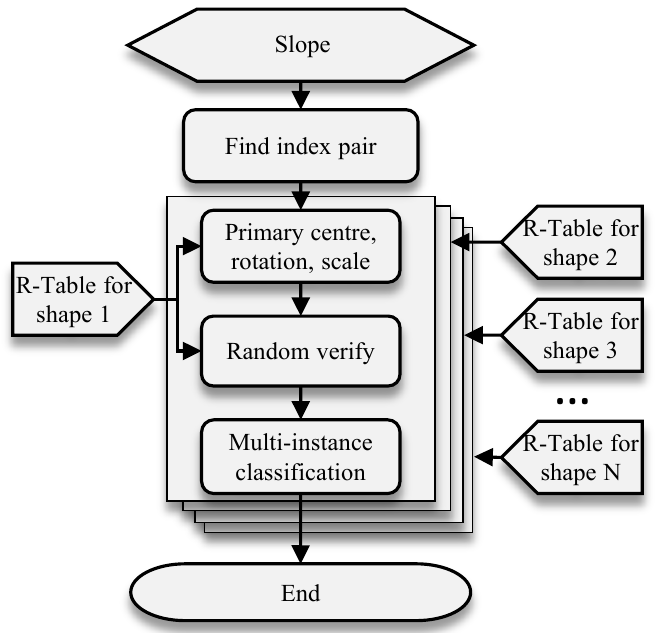
Figure 4. The detection process of the